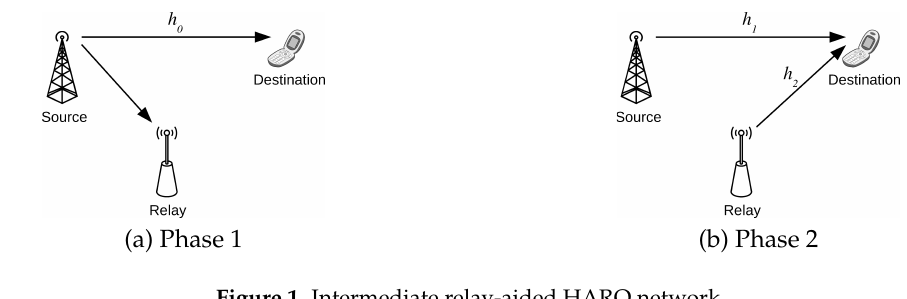
Figure 1. Intermediate relay-aided HARQ